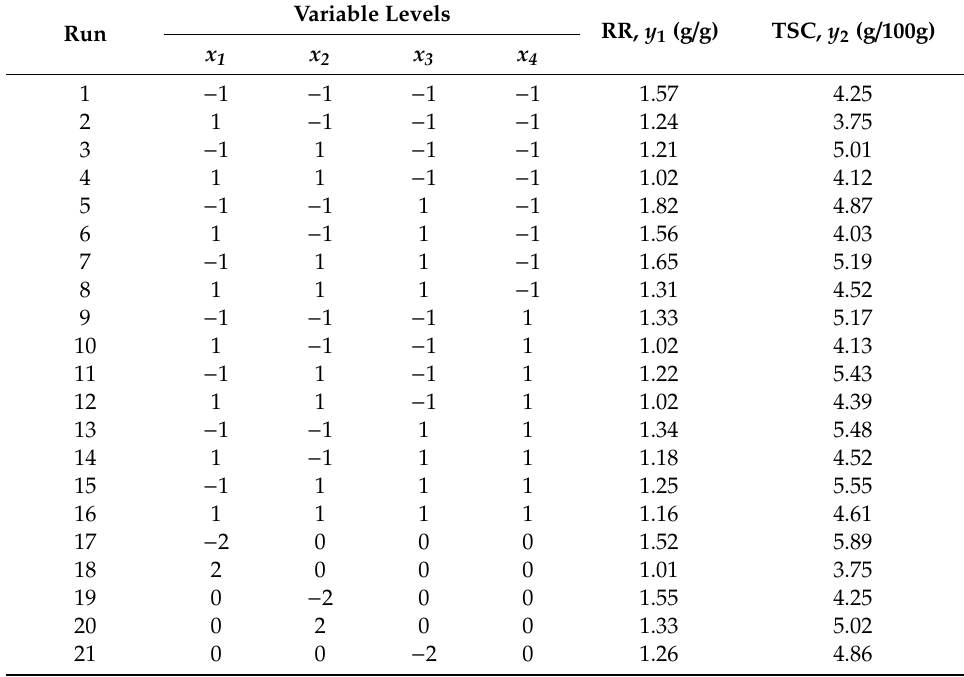
Table 3. Experimental design and RR and TSC values from response surface analysis. Variable Run